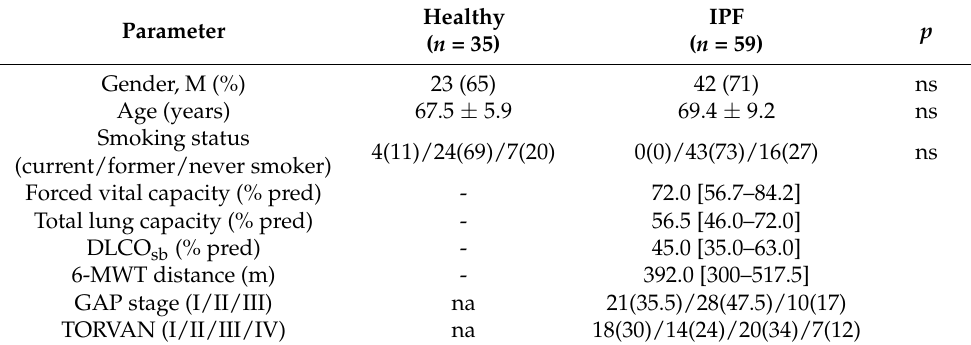
Table 1. Demographics and clinical characteristics of the study population.